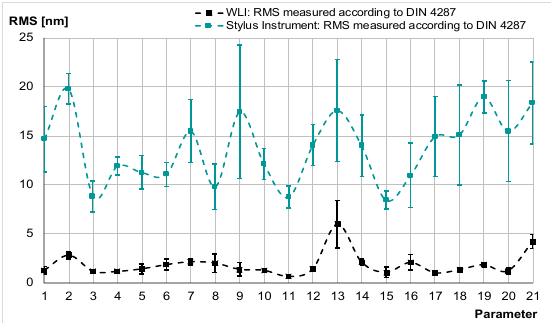
Fig. 6. Representation of the measured roughness values as a function of the parameter sets for the change in line energy. Further information on the shape deviation, waviness and roughness parameters is provided by the PSD functions in Fig. 7. The measurement results were recorded for two phases. Firstly, after preheating and secondly, after postheating. As expected, significantly higher values are illustrated by the curve after the preheating phase. The increased mid spatial frequencies values after postheating, which are typical for the laser polishing process, can also be seen.